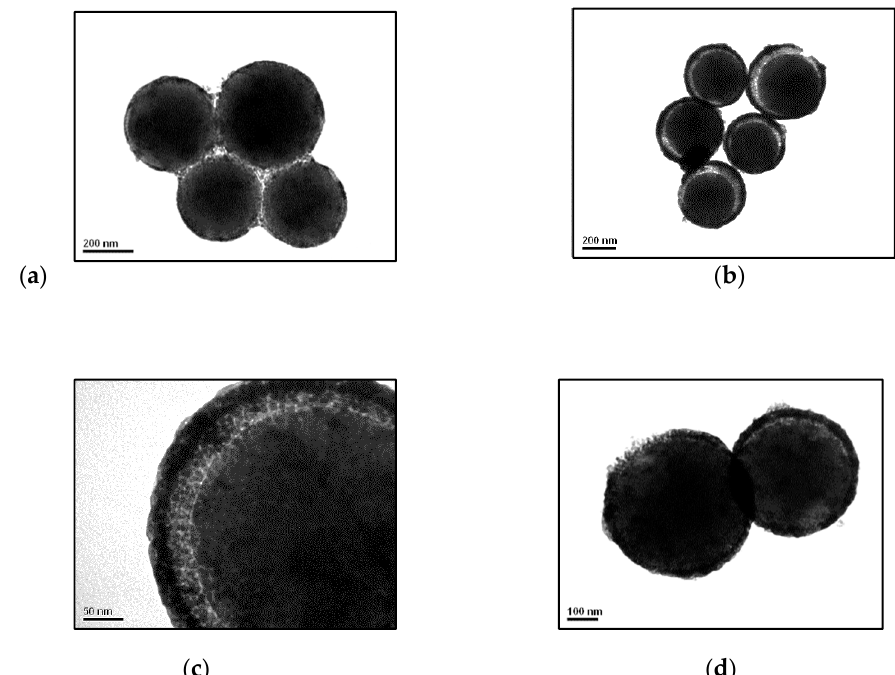
Figure 4. TEM micrographs of SiO 2 @ZrO 2 –CaO calcined at 700 °C; ( a ) 0.04M, ( b ) 0.06M, ( c ) Zoom 0.06M, ( d ) 0.08M.